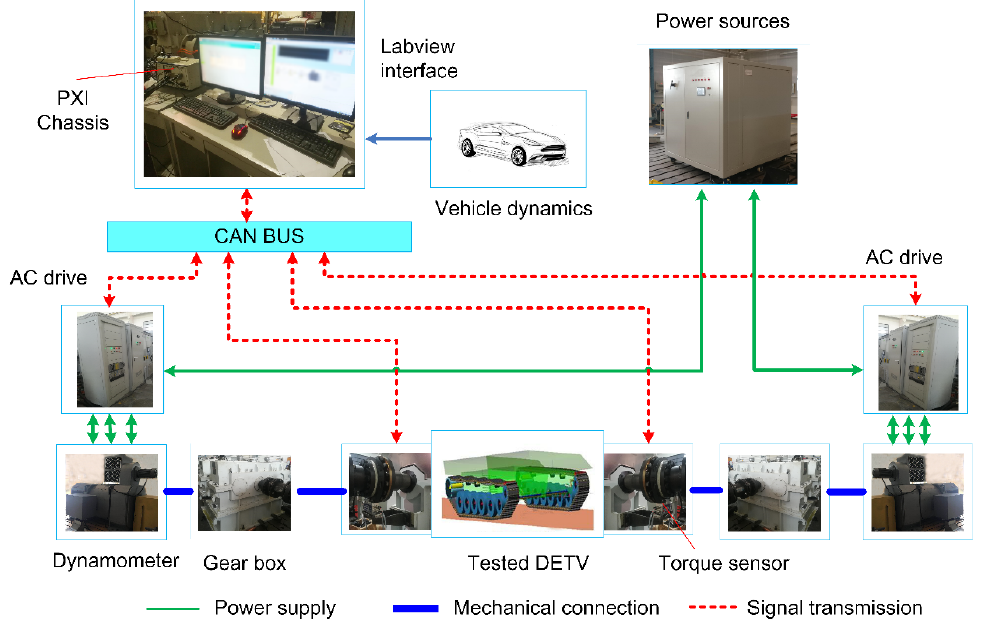
Figure 10. Block diagram of the test bench.